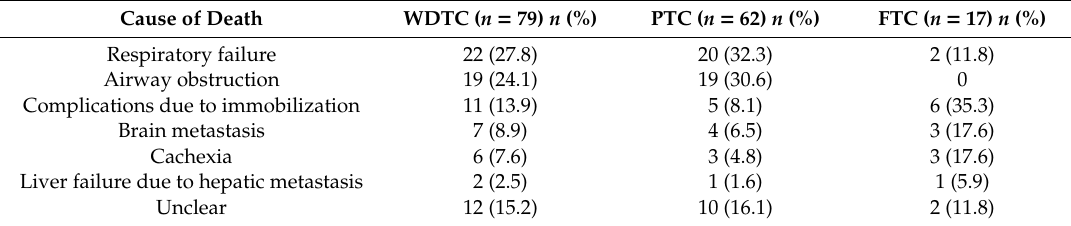
Table 3. Immediate cause of